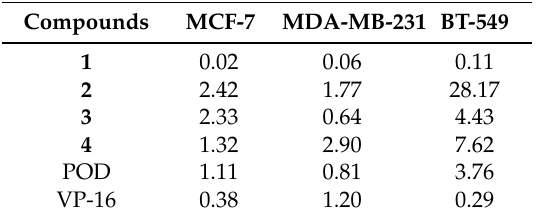
Table 3. Selectivity index of compounds ( 1 – 4 ) and controls (POD and